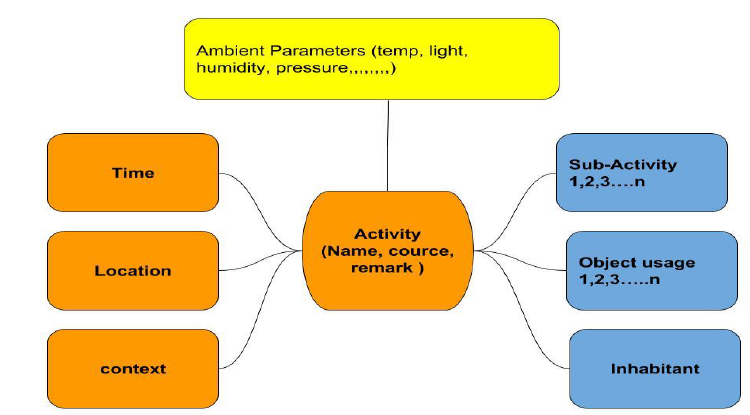
Figure 6. Activities of daily living.